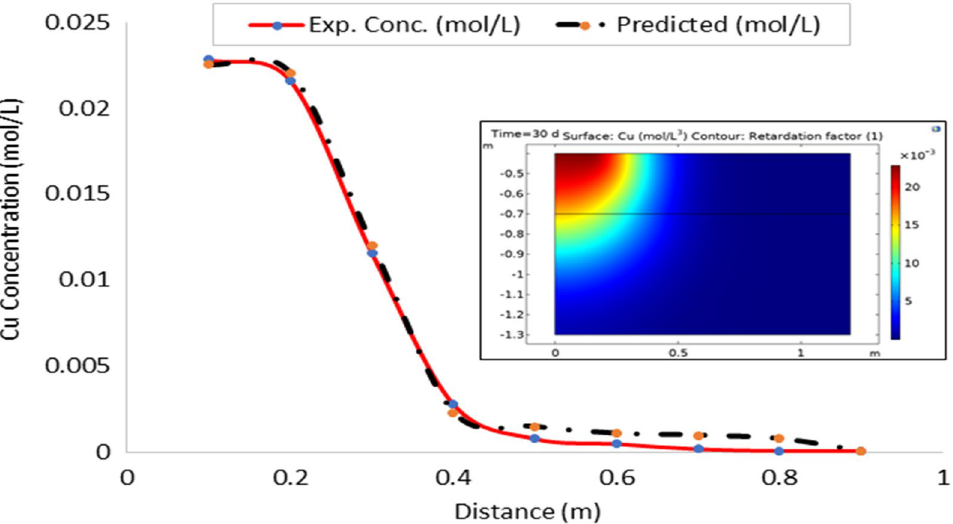
Figure 11. Cu transport in dumpsite soil of the study area.